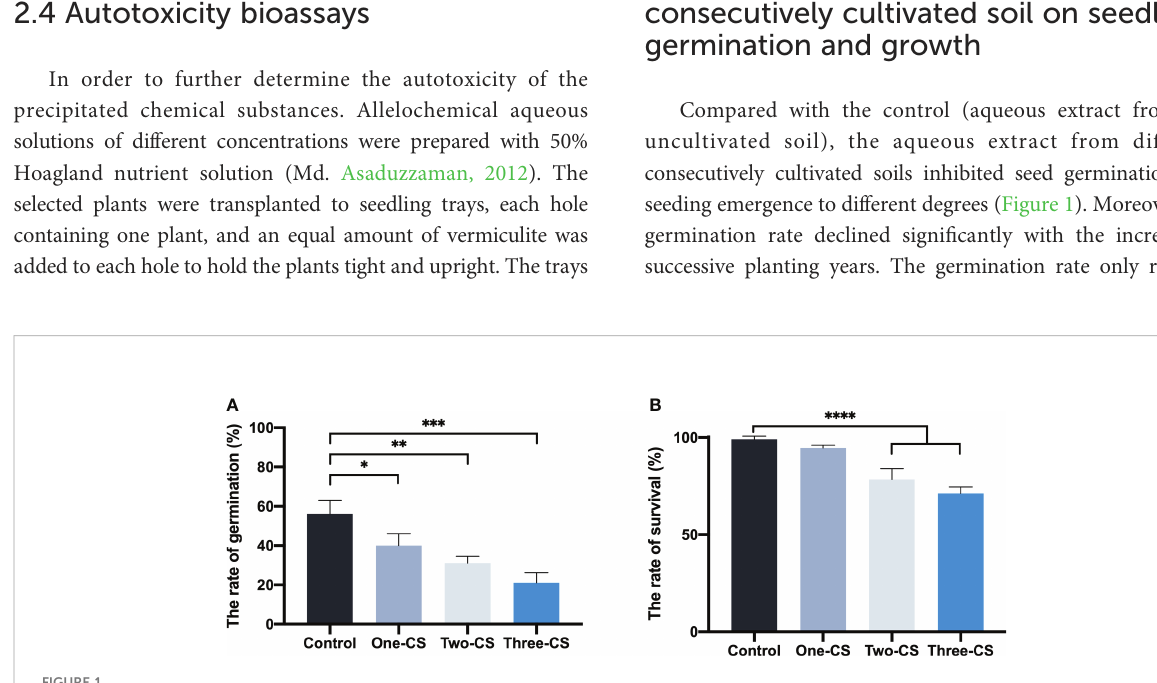
FIGURE 1 Effects of aqueous extract from consecutively cultivated soil on seedling germination rate (A) , and seedling survival rate (B) . Control represents the aqueous extract from the uncultivated soil, and One-CS, Two-CS, and Three-CS represent the aqueous extract from one, two, and three years of continuously cultivated soil. Values presented are means. Error bars represent the standard error of three replicates. Asterisks indicate statistically signi fi cant differences of treatment compared with control. *, p < 0.05; **, p < 0.01; ***, p < 0.005; ****, p < 0.001, LSD